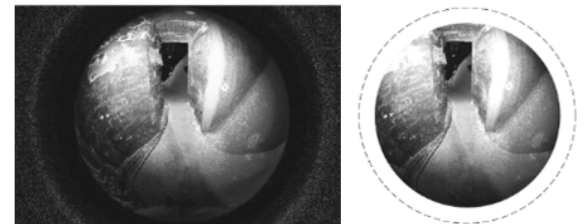
Figure 3. Original picture taken using a fisheye lens and the same image cropped to comply the desired scale.